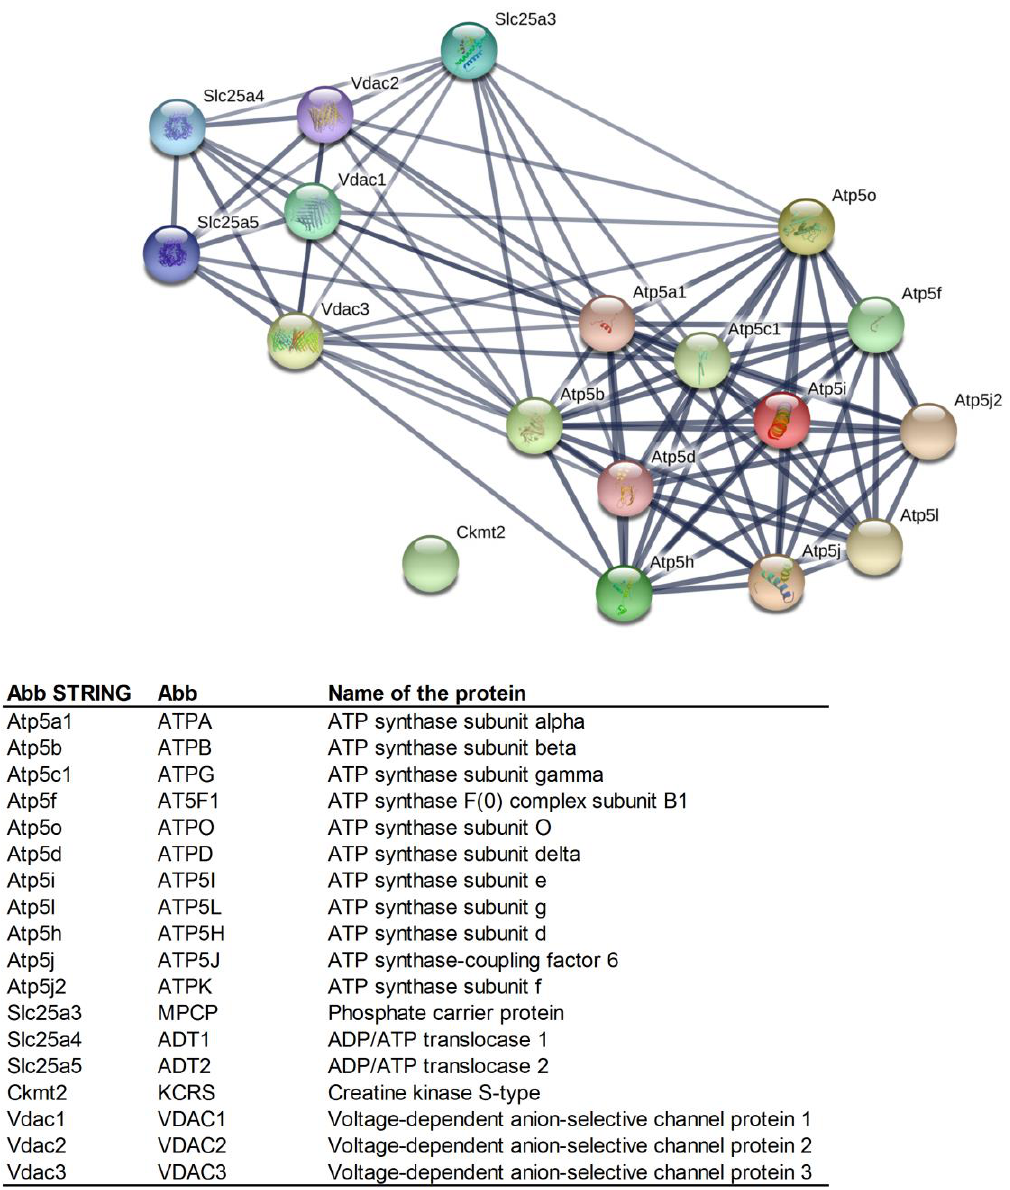
Figure 1. Mutual protein interactions among the proteins identified as being involved in the structure and regulation of mitochondrial permeability transition pores (mPTPs) (created by STRING software) [36]. Minimum required interaction score: high confidence (0.700). Line thickness indicates the strength of data support. Abbreviations of the protein names are in the legend below STRING network.